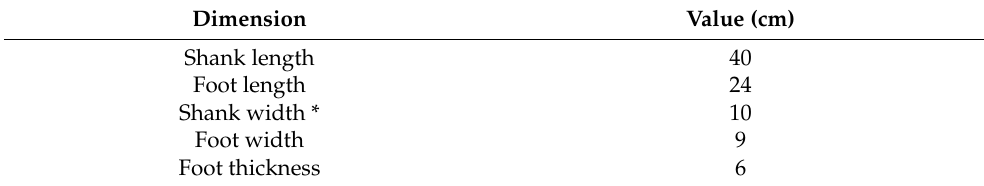
Table 1. Shank and foot segment